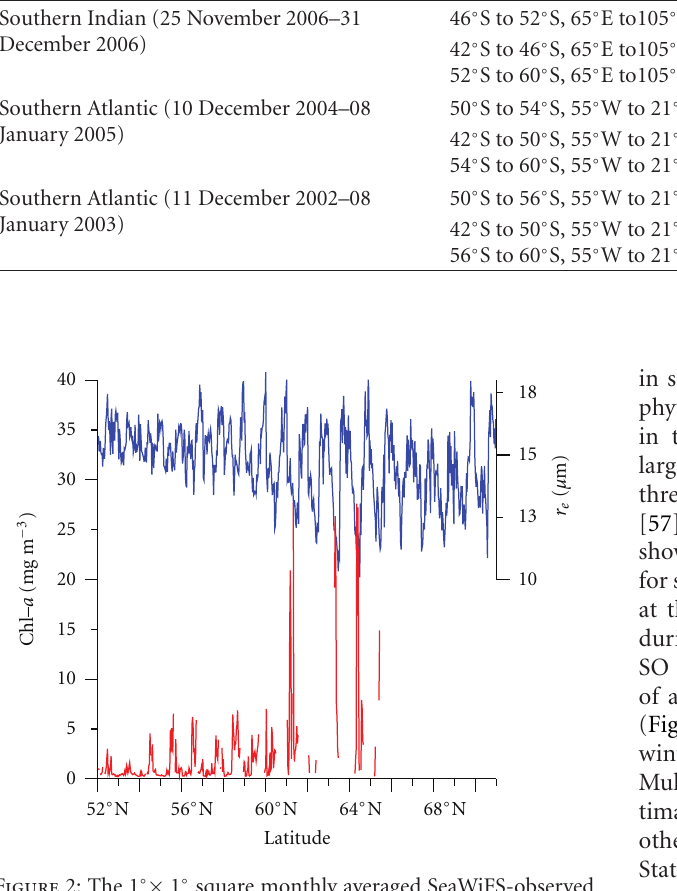
Figure 2: The 1 ◦ × 1 ◦ square monthly averaged SeaWiFS-observed [Chl- a ] (red) and MODIS cloud e ff ective radii (blue) over the Bering Sea. Between every tick marker on the x -axis, there are 35 data points corresponding to the starting point of the next west- to-east row in the longitudinal direction (176 ◦ E to 150 ◦ W). The large portion of the [Chl- a ] data is missing due to the inclusion of continental